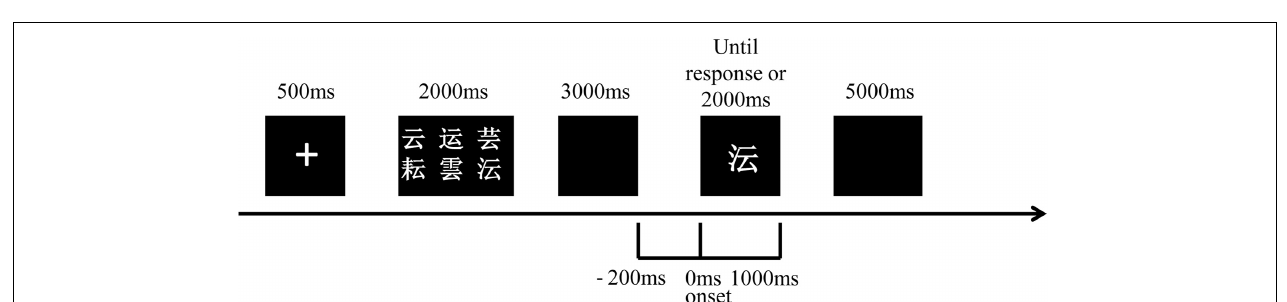
FIGURE 1 | Schematic representation of the visual DMS task used for ERP recordings. A set of six Chinese characters (sample stimulus) was displayed after a single of “+” and was required to be remembered by participants. After a blank for 3000 ms, a character (probe stimulus) presented for 2000 ms and the answer of “yes” or “no” was required to decide whether this character was a member of the set of characters or not. The inter-trial interval was 5000 ms. The retrieval period is from 200 ms before probe stimulus onset to 1000 ms after.